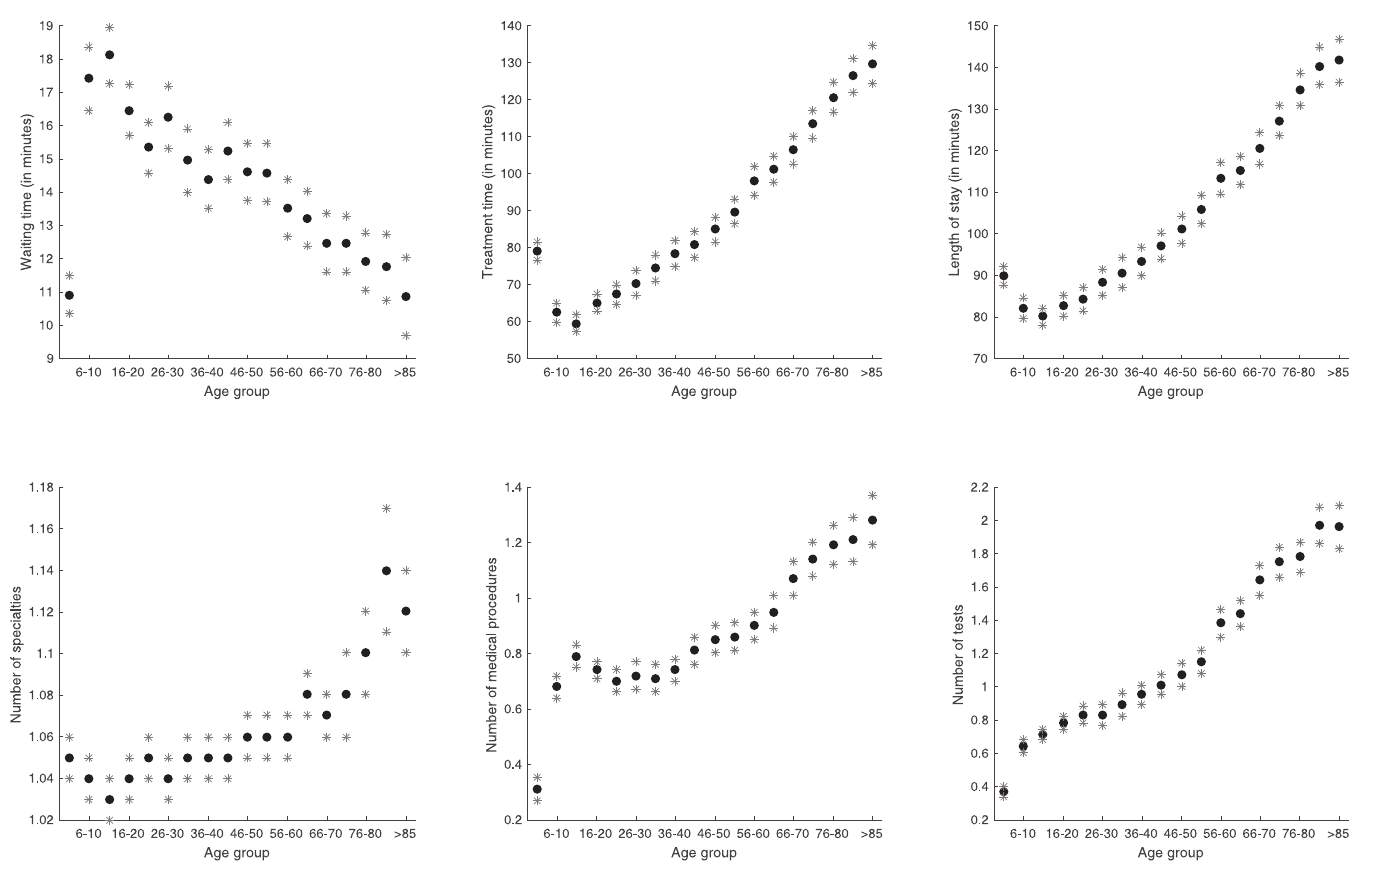
Fig 2. Graphical representations of the means of the variables length of stay, waiting time, treatment time, number of medical procedures performed, number of specialists involved in treatment and number of test performed for each age group. The asterisks indicate the boundaries of the 95% confidence intervals.